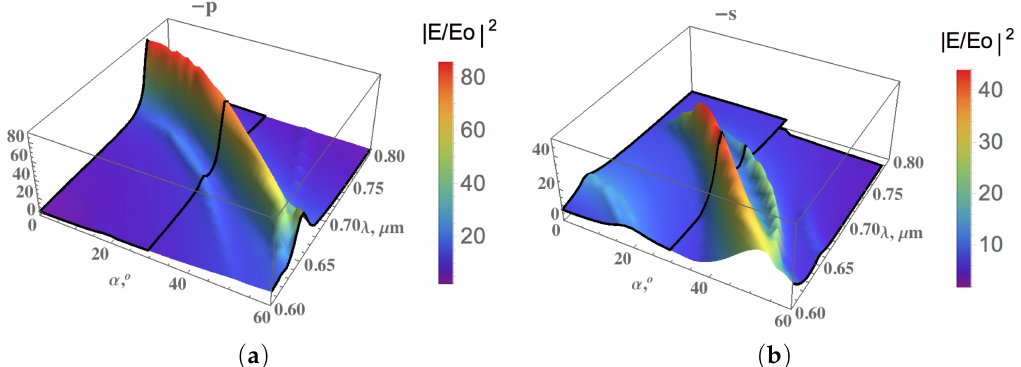
Figure 14. Intensity of electric field | E / E 0 | 2 on top of PMMA bars for different wavelength λ and incidence angle α for ( a ) p- polarized wave and ( b ) s- polarized wave. The parameters are: an azimuthal angle of φ = 2 ◦ , a period of L = 635nm, a bar width of D = 313nm, a bar height of H PMMA = 124nm, a refractive index of PMMA: n PMMA = n 1 + in 2 with n 1 = 1.5 and n 2 = 0.001, and the thickness of the gold substrate is H Au = 100nm (from